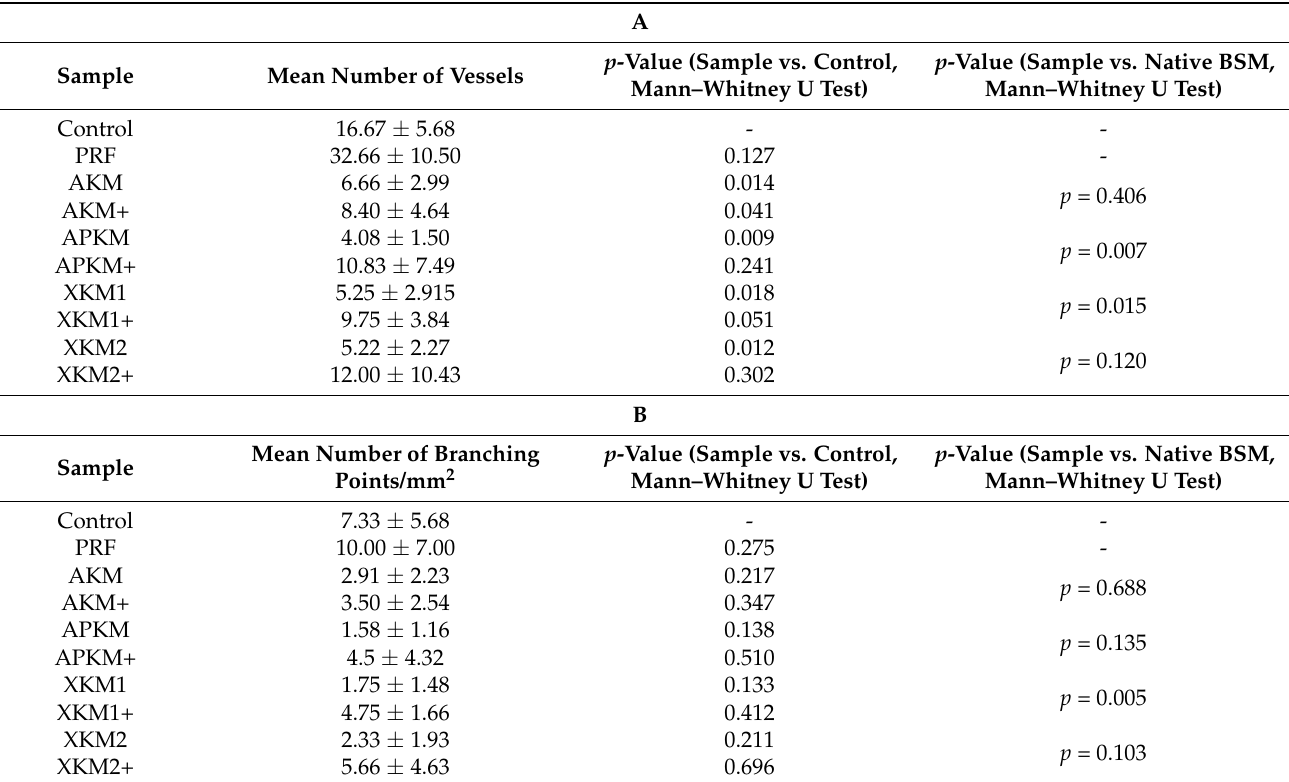
Table 3. Mean vessels/mm 2 ( A ) and branching points per mm 2 ( B ) after 24 h of incubation of each sample within the CAM assay in comparison to the negative control and PRF alone, evaluated via light microscopy. p -values are given for a comparison of each sample with the control and with their native BSM (Mann–Whitney U